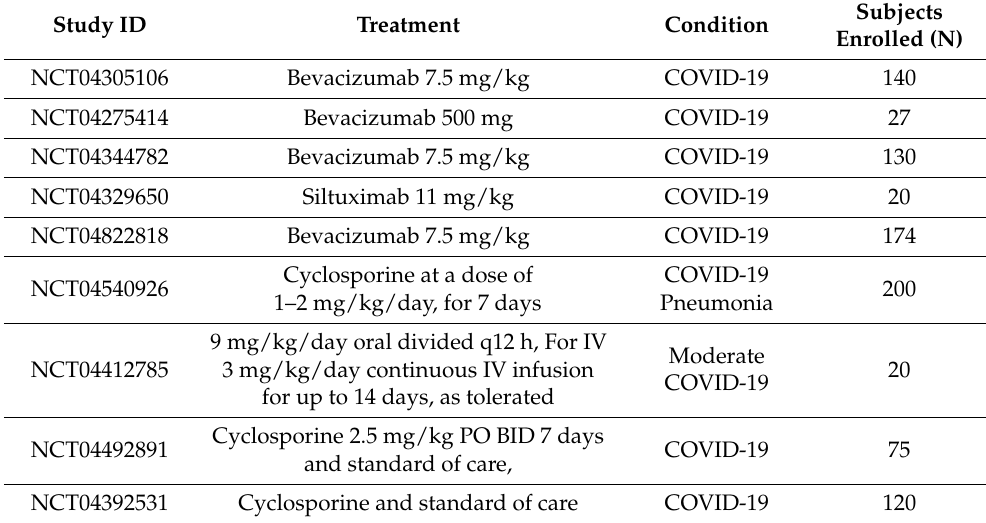
Table 1. Clinical trial employing angiogenesis interacting agents in COVID-19